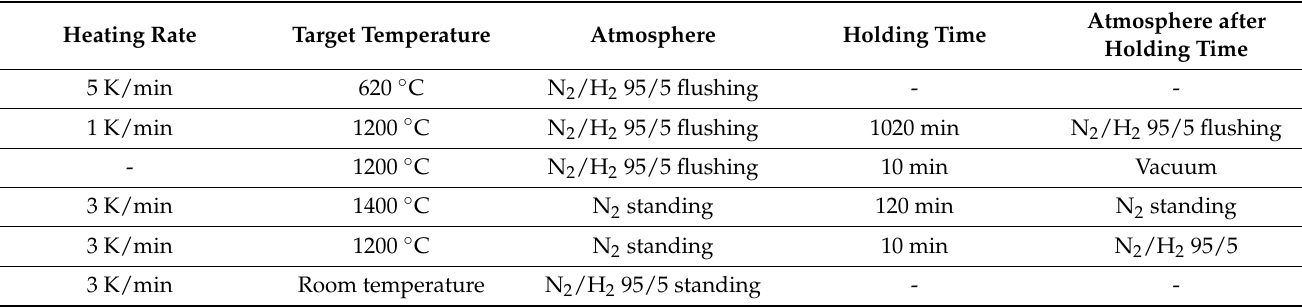
Table 2. Sintering regime of TiO x –ZrO 2 composite components with reduction of TiO 2 to TiO x . Heating Rate Target Temperature Atmosphere Holding Time